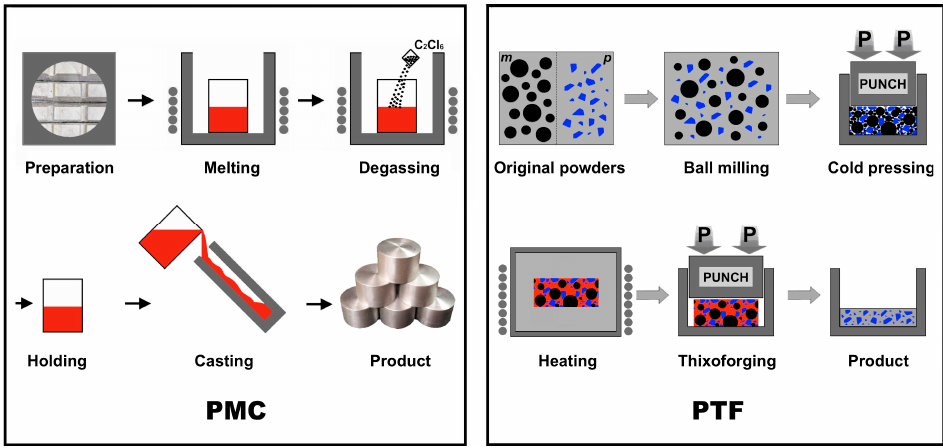
Figure 1. Schematic illustration of the PMC and PTF process ( m : matrix; p : SiC p ).